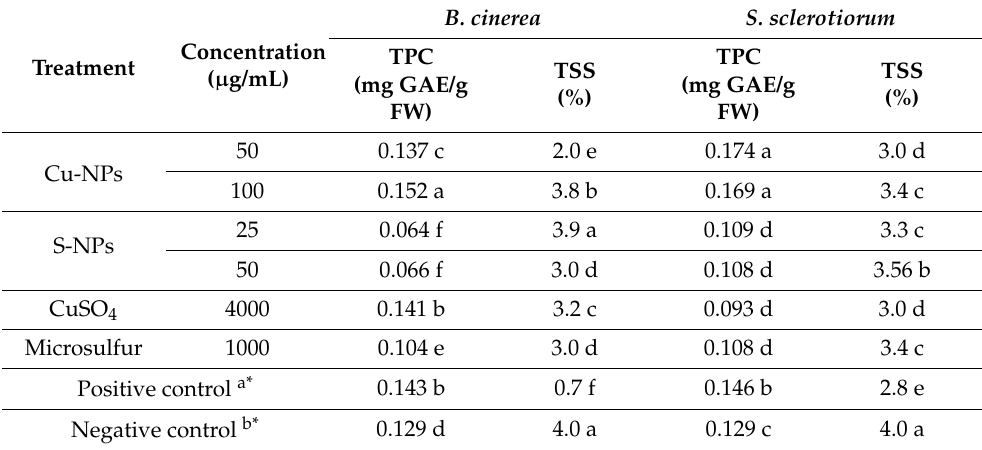
Table 3. Effect of Cu-NPs and S-NPs at different concentrations on the total phenolic (TPC) and total soluble solids (TSS) contents in cucumber fruits inoculated with B. cinerea and S. sclerotiorum.